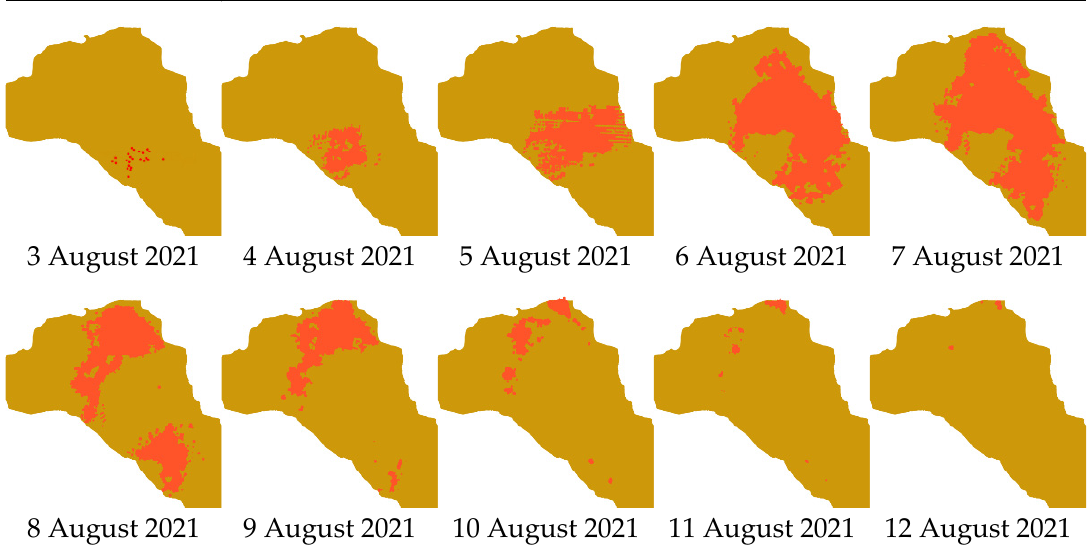
Figure 13. The evolution of fire, related to forests’ clustering, calibrated by the reports of 112 Emer ‐ gency Communications Service [80].